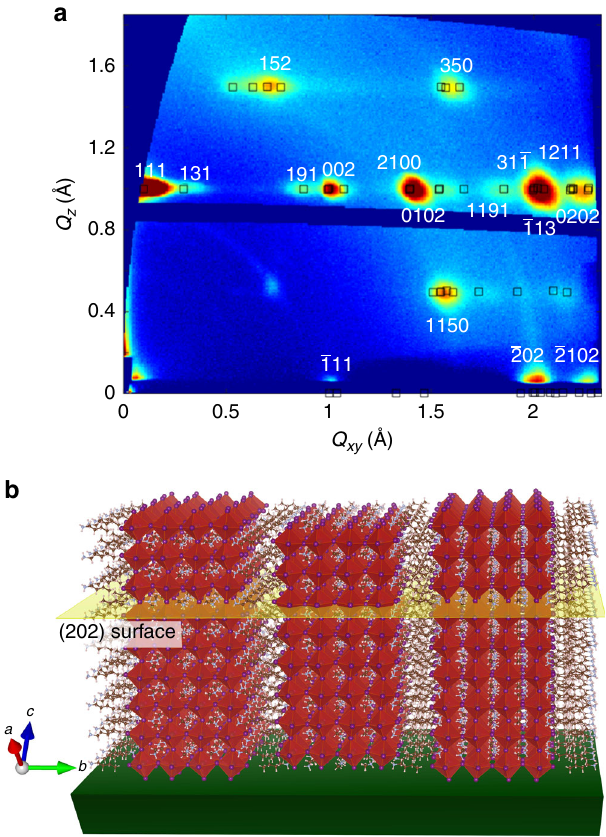
Fig. 1 GIWAXS pattern with indexing and illustration of the crystallographic orientation. a GIWAXS pattern of a BA 2 MA 3 Pb 4 I 13 thin fi lm